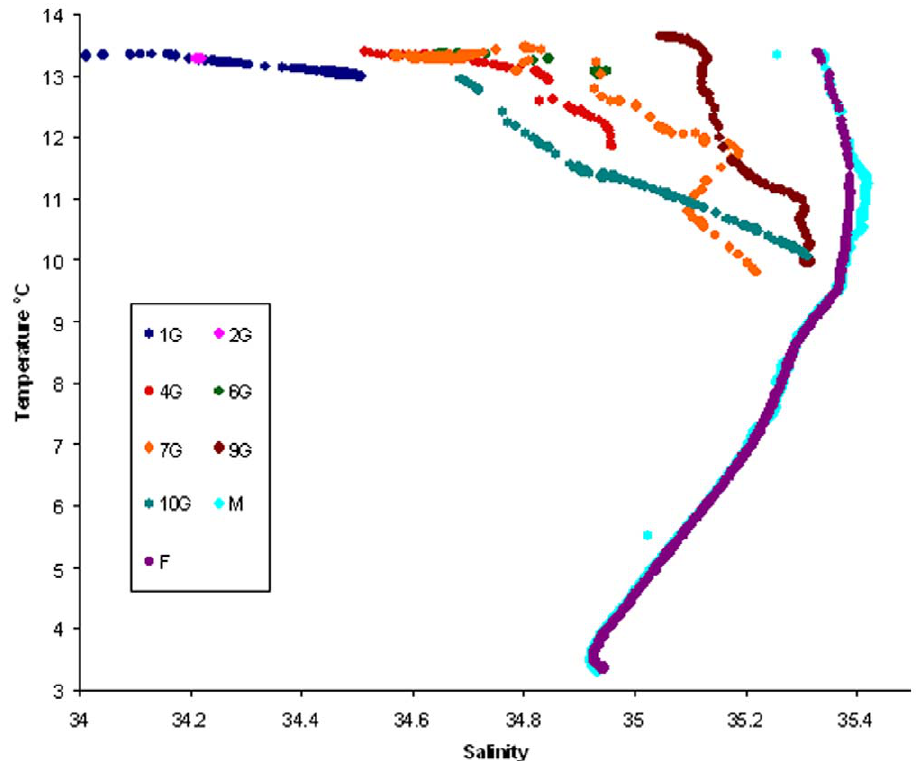
Figure 3. Temperature-salinity diagram of all sampled stations.